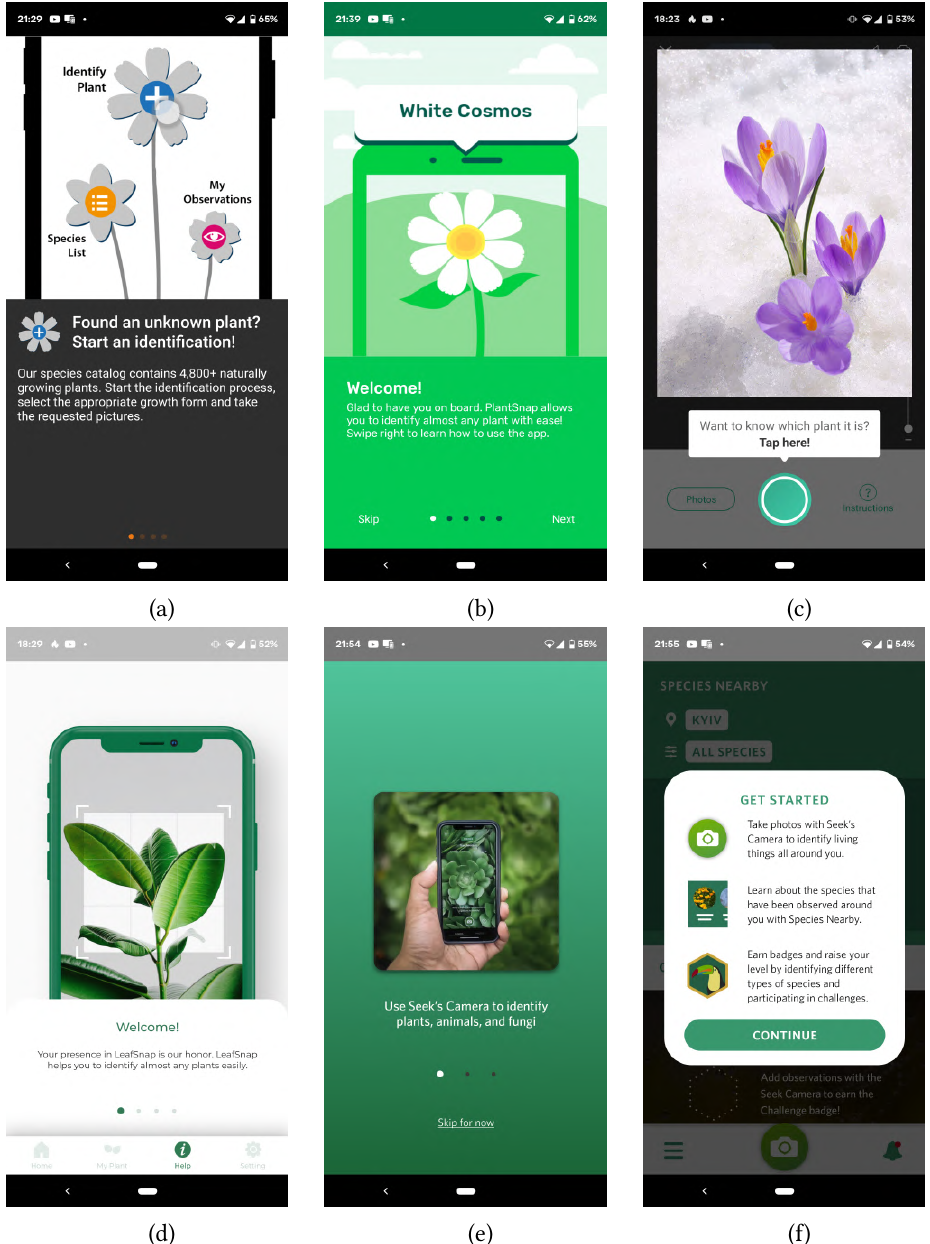
Figure 2: Instructions in Flora Incognita (a), PlantSnap (b), PictureThis (c) LeafSnap (d) and Seek (e, f)